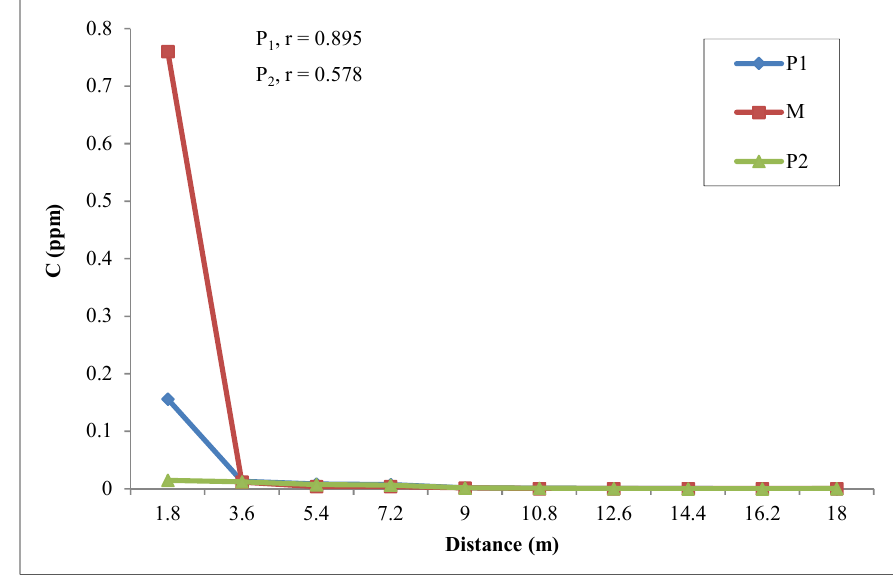
Figure 7. Measured and Predicted Concentrations against Distance for the month of November.